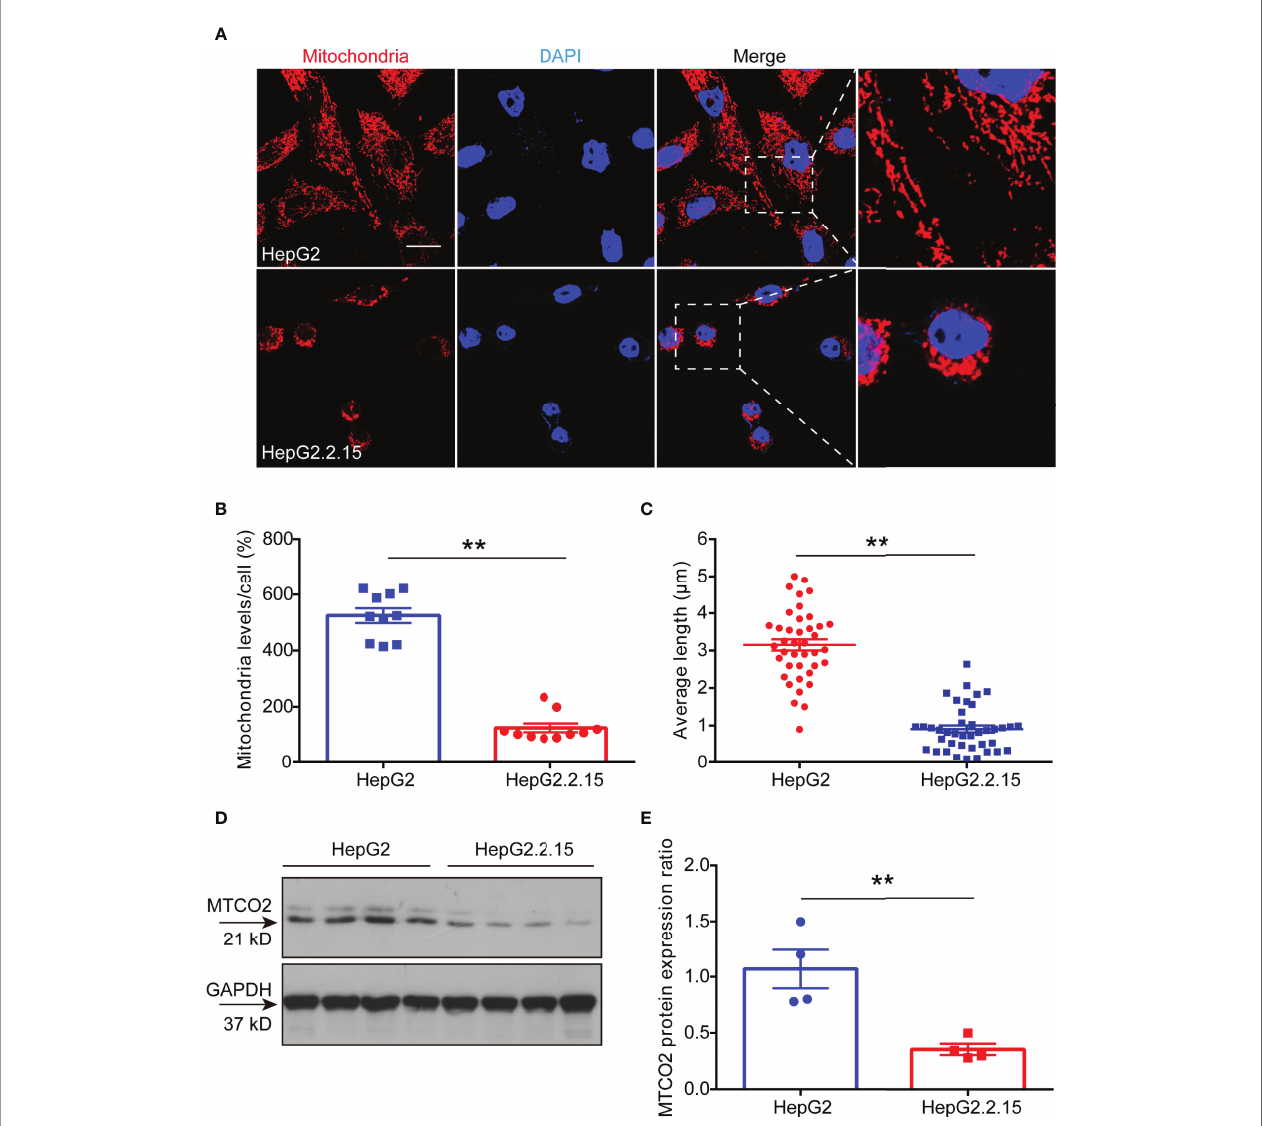
FIGURE 4 | HBV lower ATP levels by disrupting the development of mitochondria. (A) Immunocytochemistry for mitochondria in HepG2 cells and HepG2.2.15 cells (scale bar, 10 m m). (B) Quantitative analysis of mitochondrial level per cell in HepG2 cells and HepG2.2.15 cells (n=10). (C) Quantitative analysis of average mitochondrial branch length ( m m) (n=40). (D, E) Western blot to detect (D) and quantitative analysis (E) of MTCO2 expression in HepG2 cells and HepG2.2.15 cells (n=4). Data are presented as means ± SEM, ** p < 0.001; one-way ANOVA post-hoc Student – Newman – Keuls